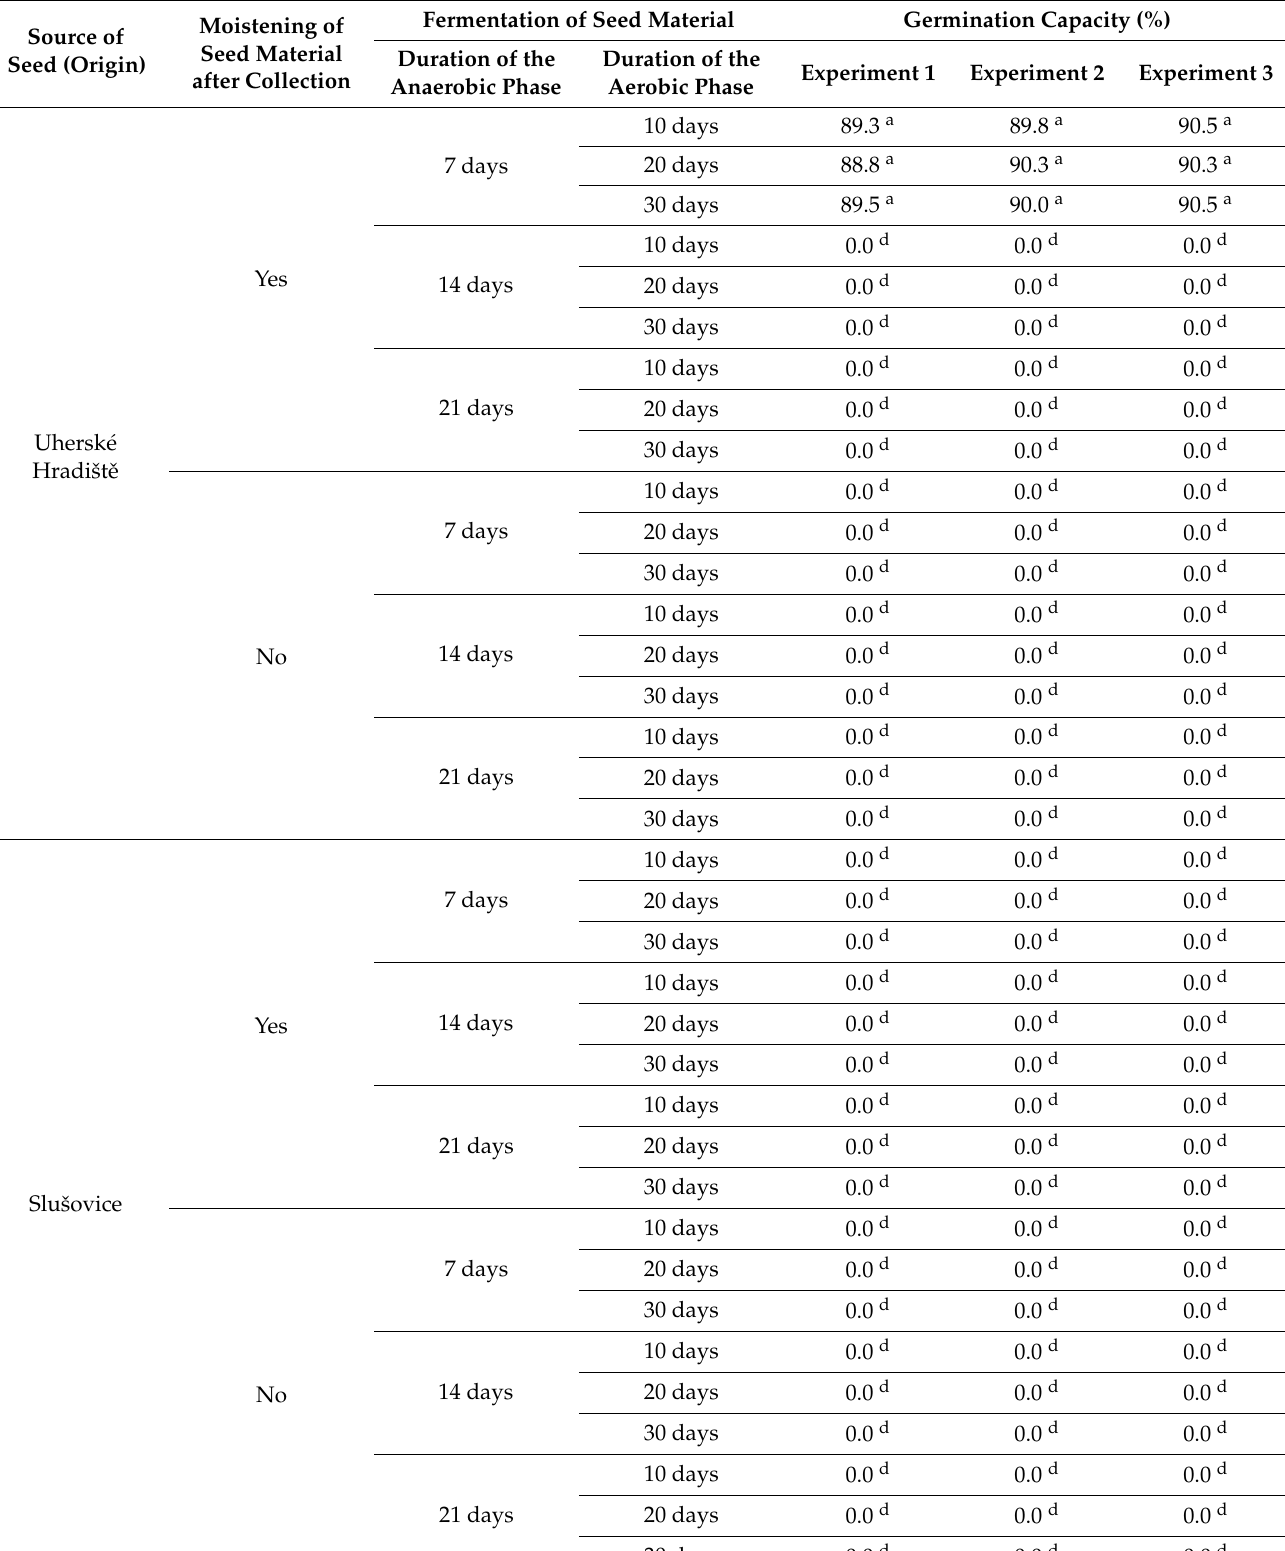
Table 2. Seed germination capacity in tested pre-sowing treatments in Experiment 1, 2 and 3 (different statistical letter indexes denote statistical differences between the various treatments in each